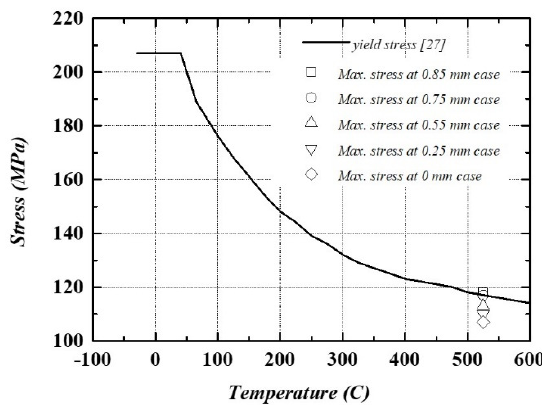
Figure 11. Maximum stress for each misalignment condition compared to yield stress of material SS316.